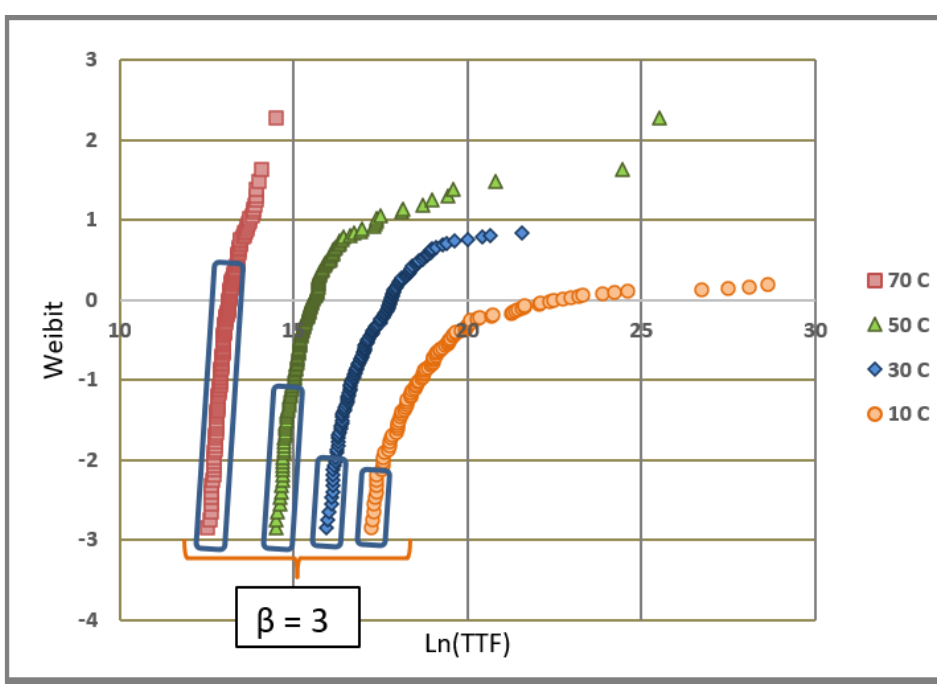
Figure 7. Weibull distributions of three-stage rings are displayed for the following four different external stress temperatures: 10, 30, 50, and 70° C. The section that conserves a characteristic β slope of three for three-stage rings is